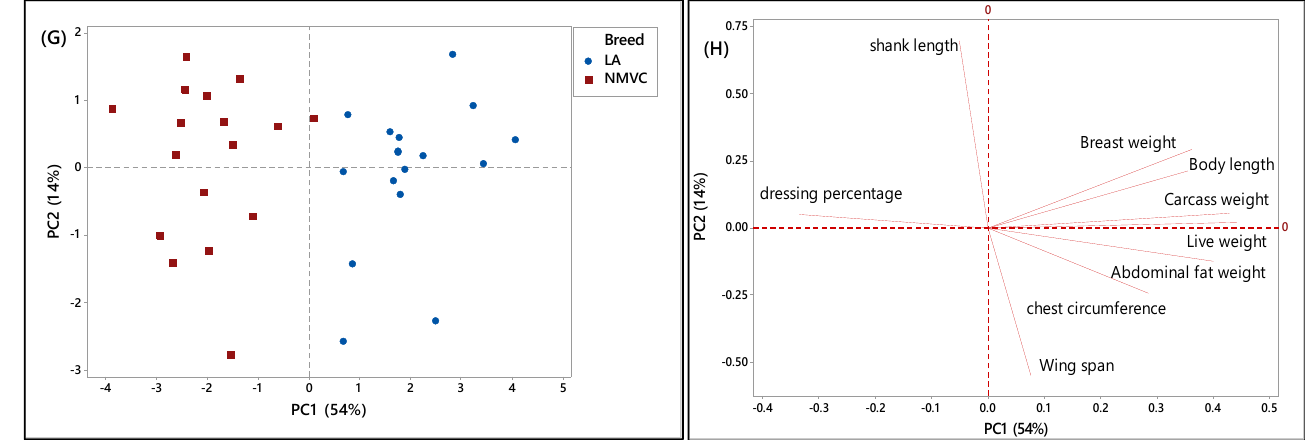
Figure 2. PCA score and loading plots showing the clustering pattern of different chicken breeds based on the nine phenotypic variables. ( A , B ) Score and loading plots of all breeds studied in the first phase, ( C , D ) naturally mated village chicken (Ayam Kampung) (NMVC) and Cobb (COBB), ( E , F ) naturally mated village chicken (Ayam Kampung) (NMVC) and Hubbard (CBH), and ( G , H) naturally mated village chicken (Ayam Kampung) (NMVC) and layer-DeKalb (LA).